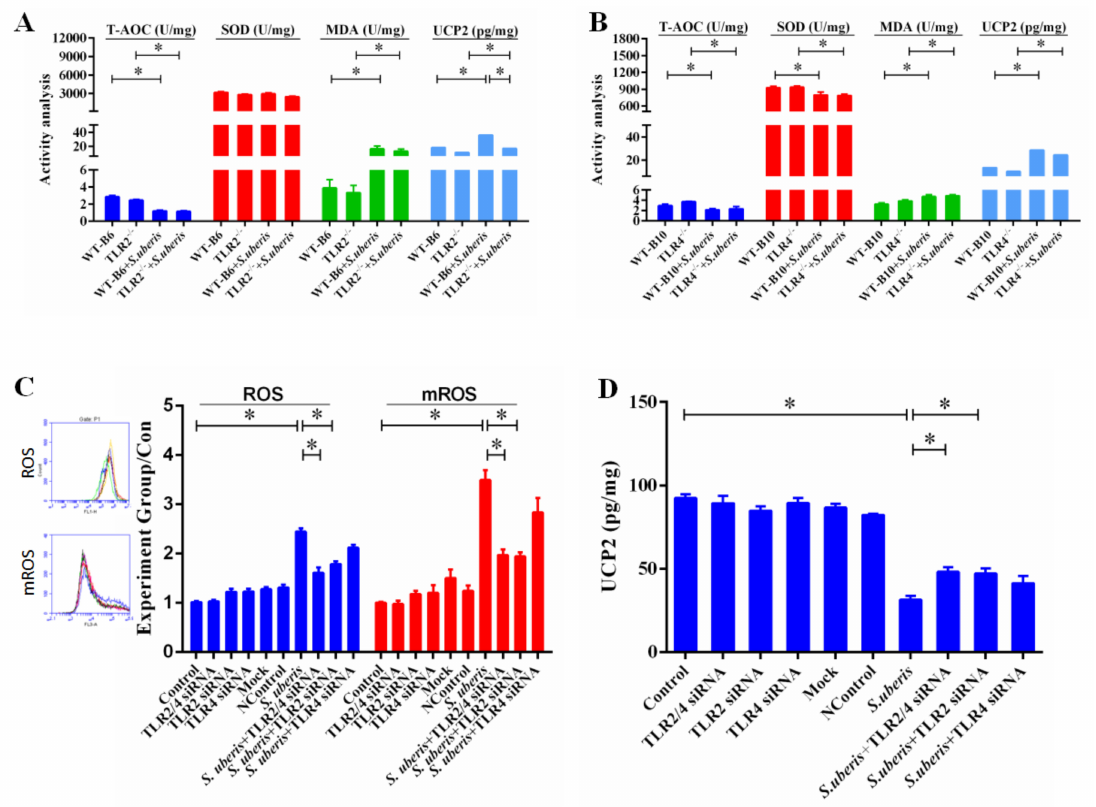
Figure 5. TLRs mediate redox status in mammary gland during S. uberis infection. ( A , B ) The protein expressions of total antioxidant capacity (T-AOC), superoxide dismutase (SOD), malondialdehyde (MDA), and uncoupling protein 2 (UCP2) were determined by kits in mammary gland of WTB6, WTB10, TLR2 − / − , TLR4 − / − mice with or without S. uberis . A is for the protein expressions for TLR2 − / − group and B is for the TLR4 − / − group. Data are presented as the means ± SEM ( n = 6). * ( p < 0.05) = significantly di ff erent between the indicated groups. ( C ) CellQuest Pro acquisition and analysis software analyzed the levels of reactive oxygen species (ROS) and mitochondrial reactive oxygen species (mROS) in MECs of Control, siTLR2, siTLR4, and siTLR2 / 4 groups with or without S. uberis . ( D ) The activity of UCP2 was determined by ELISA in MECs of Control, siTLR2, siTLR4 and siTLR2 / 4 groups with or without S. uberis . Data were presented as the means ± SEM ( n = 3). * ( p < 0.05) = significantly di ff erent between the indicated groups. All experiments were repeated three